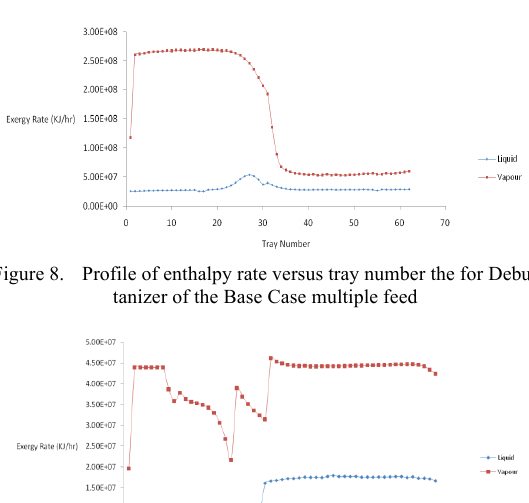
Figure 7. Profile of exergy rate versus tray number the for Depro- panizer of the Base Case multiple feed